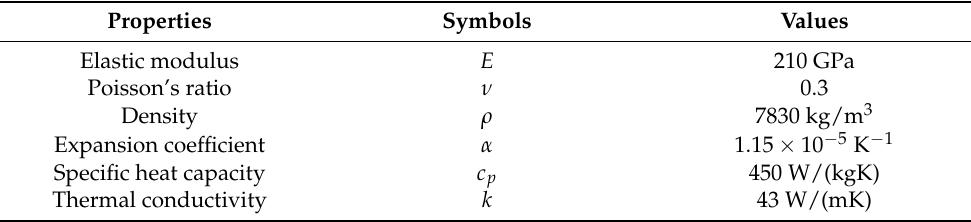
Table 5. Thermal and mechanical properties of AISI